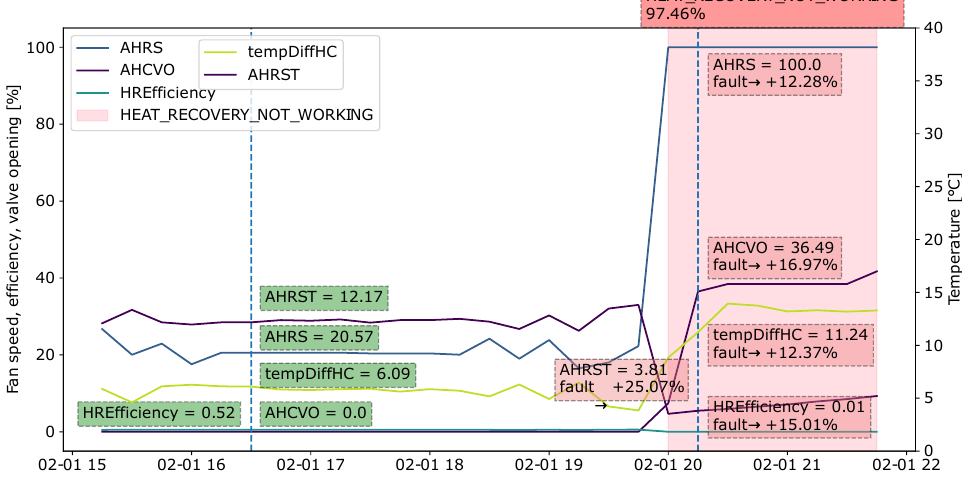
Figure 11. Explanation visualized as a sliding window for the fault type “Heat recovery not working” during an observation period from 15:00 to